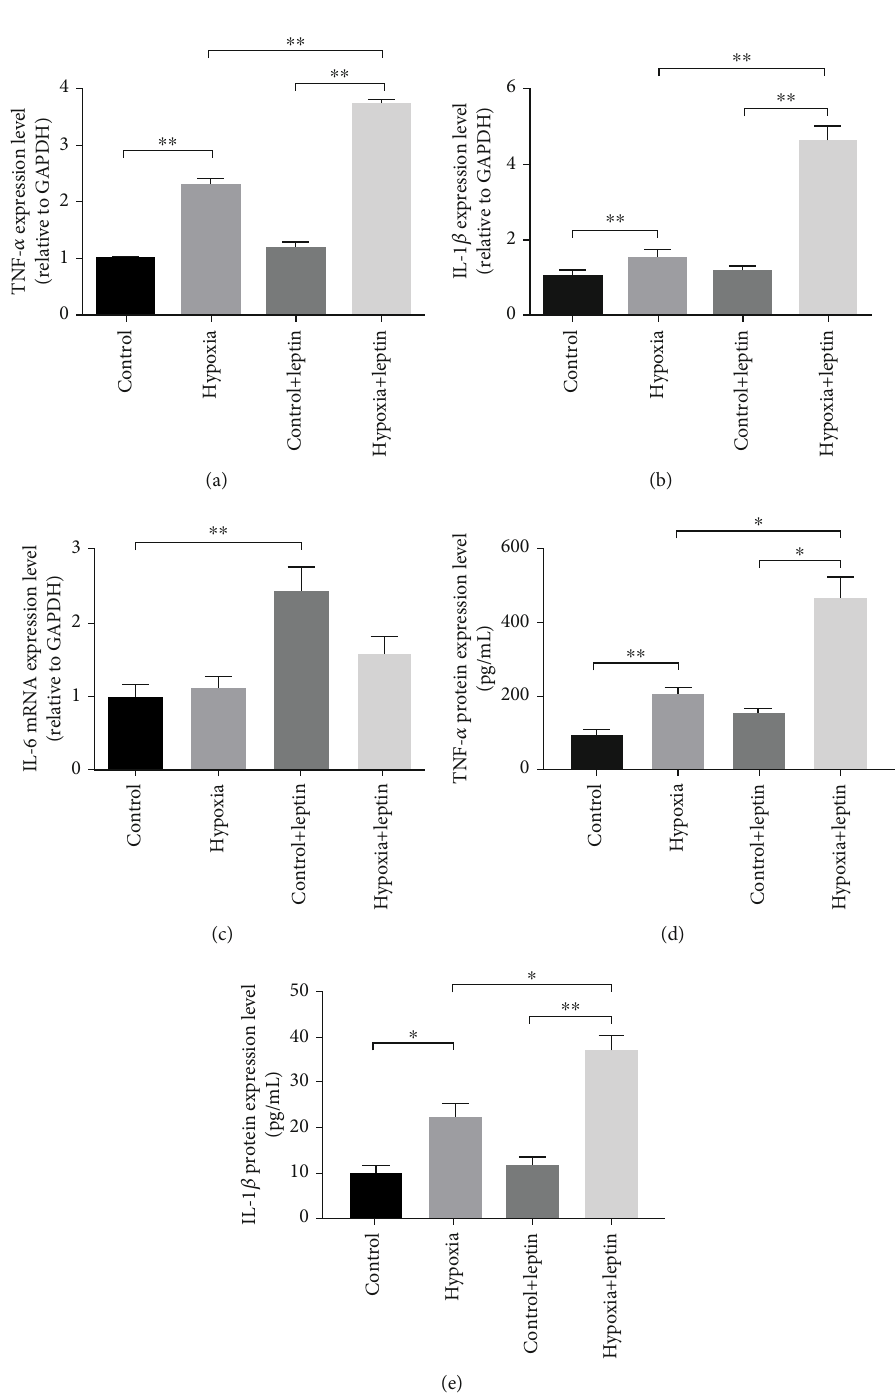
Figure 7: Expression of proin fl ammatory cytokines TNF- α (a) and IL-1 β (b) in BV2 cells under normoxia/hypoxia conditions with/without leptin treatment for 24 hours. The mRNA expression levels of TNF- α (a), IL-1 β (B), and IL-6 (c) were examined by real-time PCR, and the protein expression levels of TNF- α (d) and IL-1 β (e) were examined by ELISA. N = 3 , p < 0 : 05 , and ∗∗ p < 0 : 01